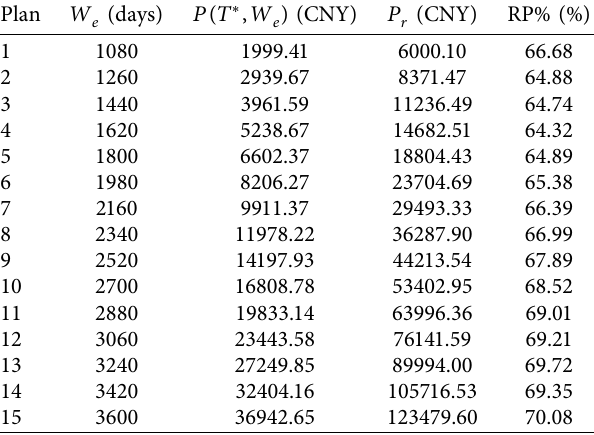
Table 4: Price decision plans corresponding to different EW